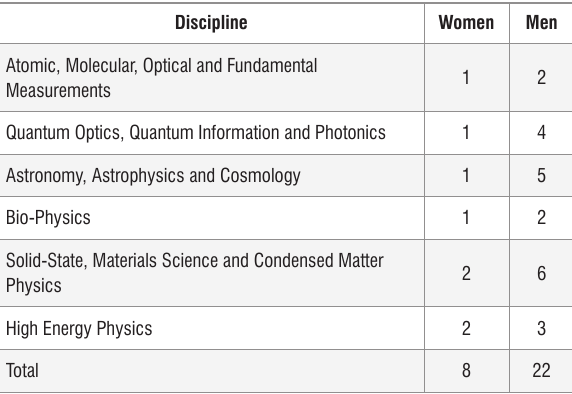
Table 4: The data (by gender) on the total number of young scientists who presented posters of their work during the meeting Discipline Women Men Atomic, Molecular, Optical and Fundamental 1 2 Measurements Quantum Optics, Quantum Information and Photonics 1 Astronomy, Astrophysics and